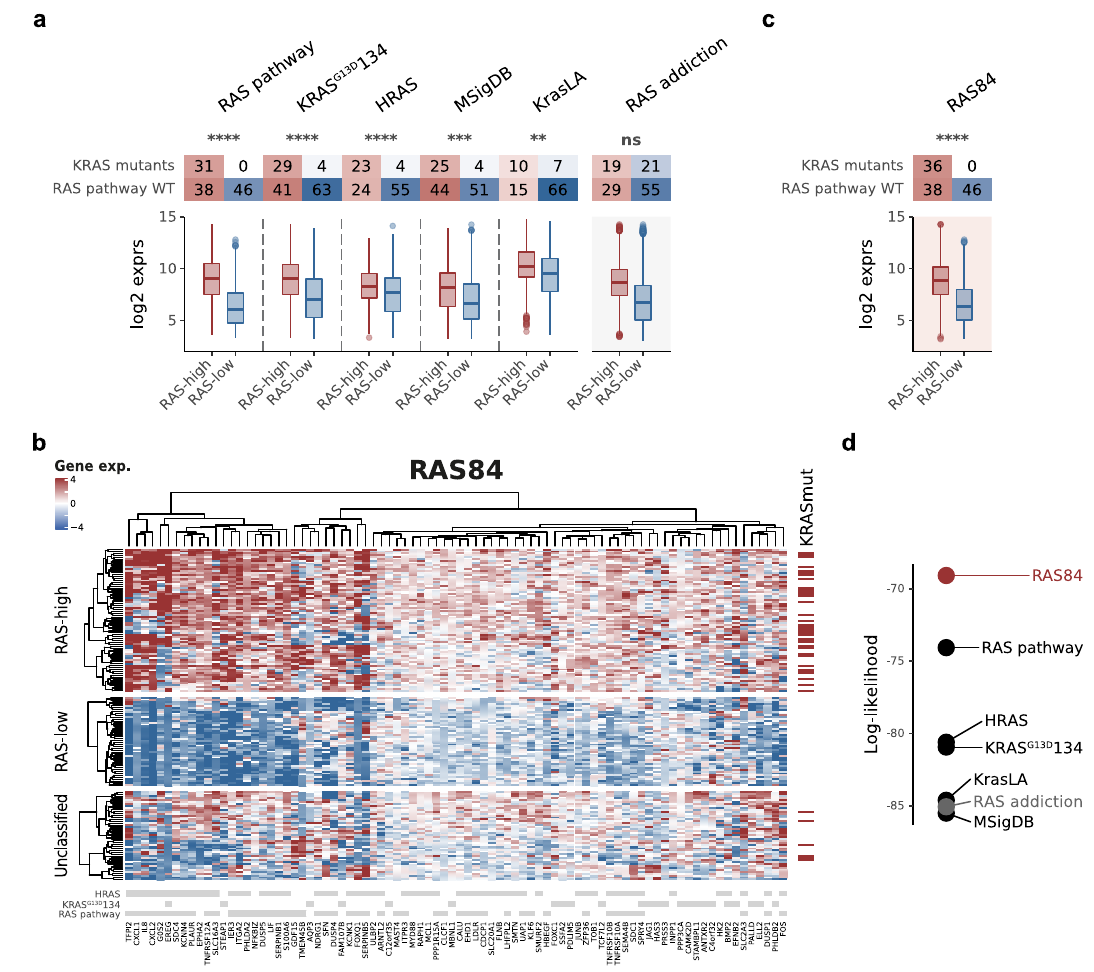
Fig. 1 | In vitro RAS signature derivation. a Contingency tables showing the number of RAS pathway wild-type and KRAS mutant cell lines per RAS-high and RAS-low groupsfor each signature. RAS pathway wild-typecelllines are those with no oncogenic mutation in any RAS pathway member. RAS-high cell counts are shown in red, RAS-lowin blue. The boxplots show the RI distributions for the RAS- high and low groups where the box shows the median and IQR, the whiskers indicate ± 1.5 x IQR, outliers lie outside thisrange. RAS addiction ispresented here as a control signature (RAS pathway n =115, KRAS G13D 134 n =137, HRAS n =106, MSigDB n =124, KrasLA n =98, RAS addiction n =124; Chisq test **** P ≤ 0.0001, *** P ≤ 0.001, ** P ≤ 0.01, n.s.= P >0.05). b Heatmap showing our RAS84 meta- signature genes mapped to fi ltered (see “ Method ” ) CCLE lung cell line data. Cell linesareshownasrows,genesascolumns.Groupingsofhigh,mediumandlowRAS